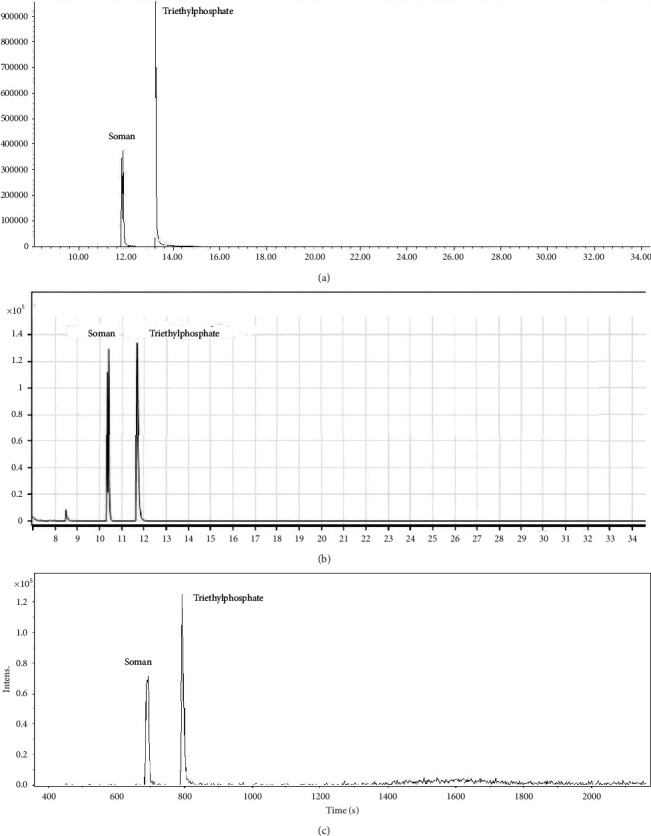
Examples of soman and triethylphosphate chromatograms extracted at m/z 99 measured on the following GC/MS systems: (a) 7890A/5975C, cCWA = 10.7 mg/L, cISTD = 15.3 mg/L, (b) intuvo 9000/5977B, cCWA = 7.3 mg/L, cISTD = 4.3 mg/L, and (c) EM 640, cCWA = 39.0 mg/L, cISTD = 31.9 mg/L.